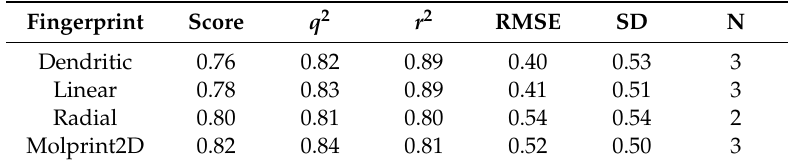
Table 5. Model performance as a function of the fingerprint types used as molecular descriptors to build the kernel-based partial least squares (KPLS)